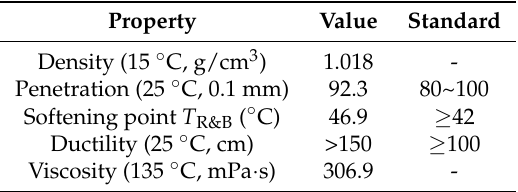
Figure 1. The Grading Curve aggregates used in this study. Table 1. Technical parameters of tested asphalt.